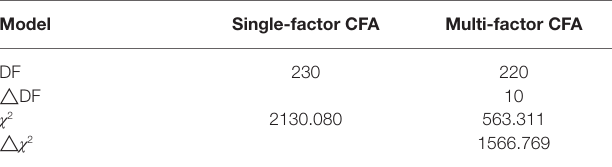
TABLE 1 | Comparison of single-factor and multi-factor model. Model Single-factor